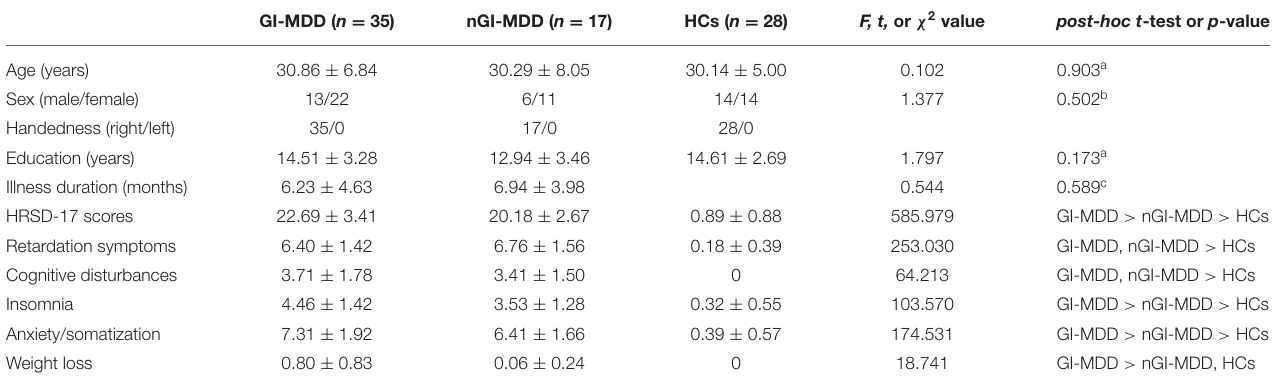
TABLE 1 | Demographic and clinical characteristics of the